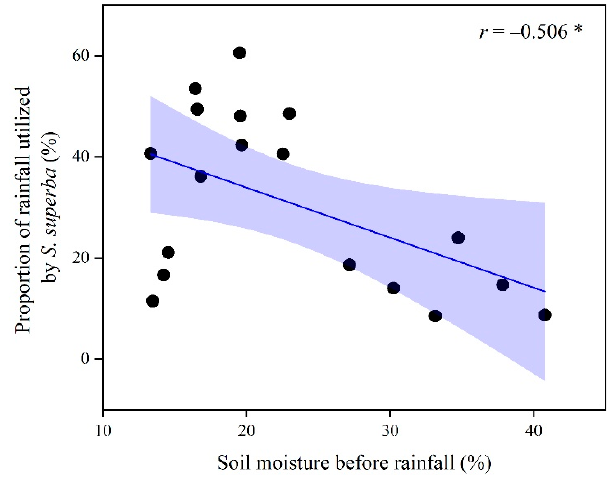
Figure 5. Relationship between the proportion of precipitation utilized by Schima superba and the soil moisture before rainfall in the monsoon evergreen broad-leaved forest. * p < 0.05.